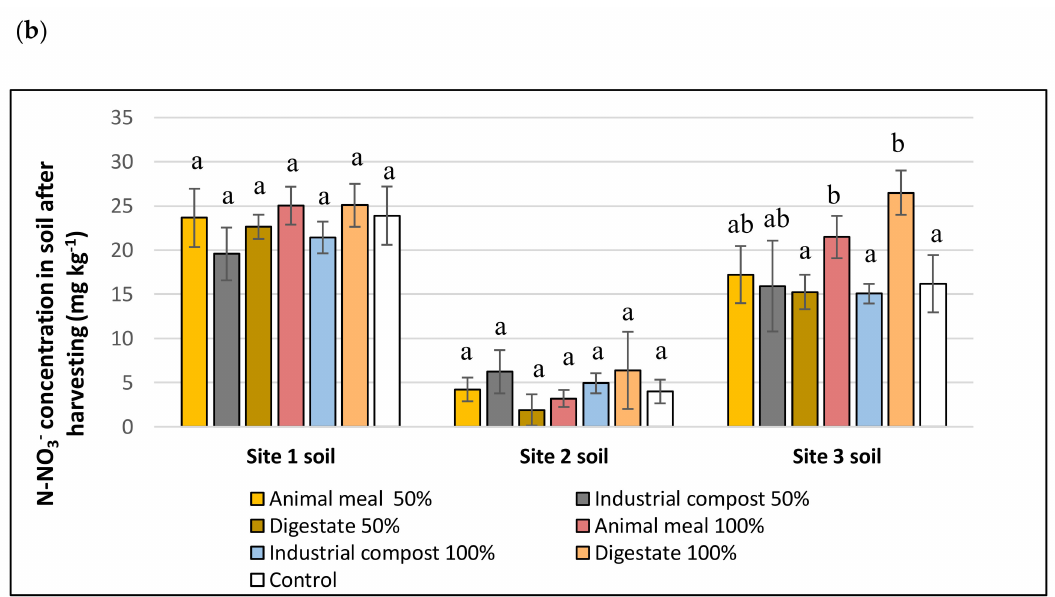
Figure 3. The contents of nitrate nitrogen (N-NO 3 − ) in Site 1, Site 2, and Site 3 soils in relation to the control: ( a ) soils before sowing; ( b ) soils after harvesting. Lowercase letters indicate significant di ff erences between the treatments, calculated separately for individual sites based on Tukey’s test. Means marked with the same letter did not di ff er significantly ( p <